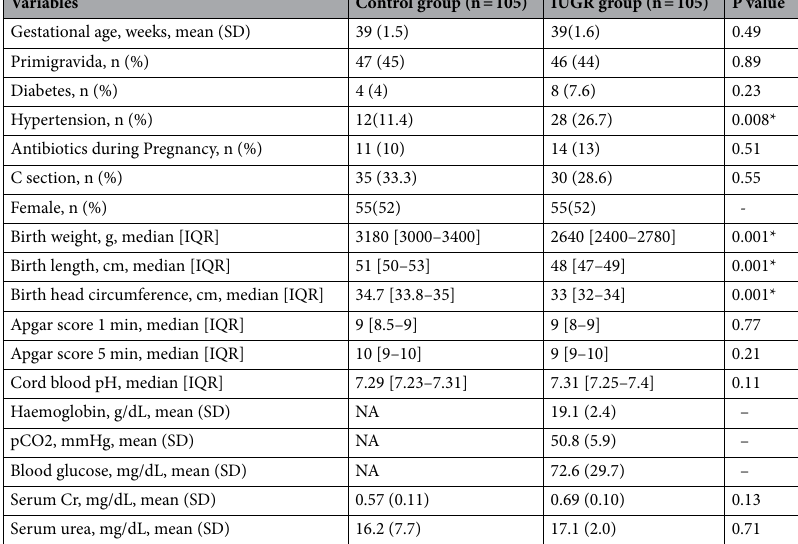
Table 1. Baseline maternal and neonatal characteristics in the IUGR and control groups. Mann–Whitney U test was used for nonparametric data, Student’s t test for parametric data, and the χ 2 test for categorical measurements. *Statistically significant (P < 0.05).